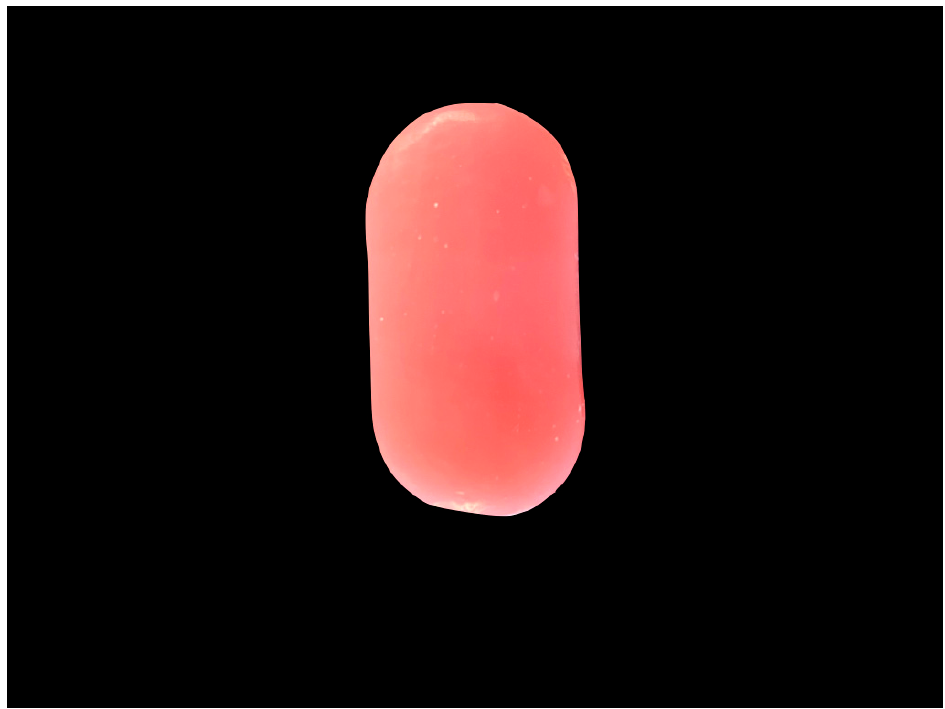
Figure 3. Polished resin sample. It shows a uniform surface with no fibers, cross linking or surface defects. Materials 2020 , 13 , x FOR PEER REVIEW